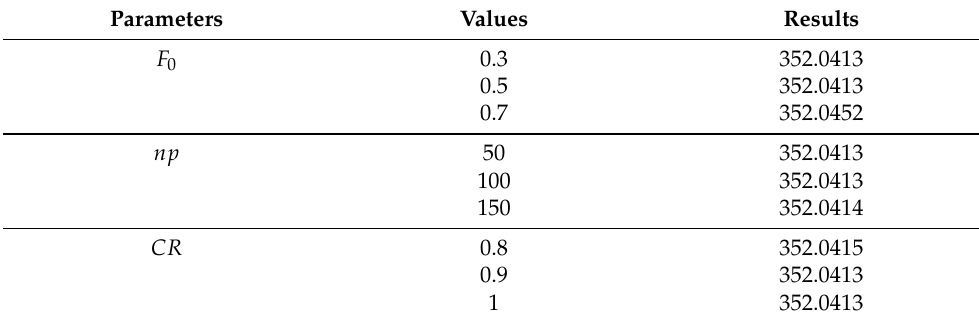
Table 7. Stability and Reliability